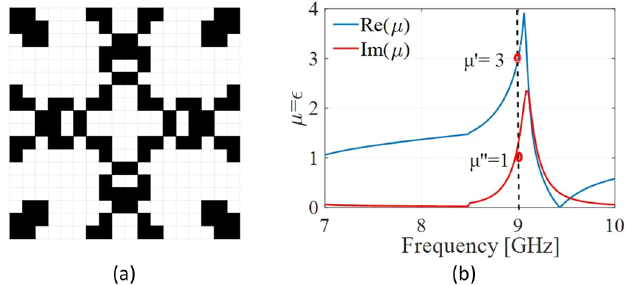
Fig. 3. (a) Optimised unit cell structure of the metaferrite surface. The black spots represent the metallized pixels which are encoded as 1, and the blank ones are unmetallized pixels which are encoded as 0. (b) Simulated real and imaginary components of m e fi nalised metaferrite substrate with e eff = eff of t 1 = 0.8mm, e 2 =6, t 2 =1.52